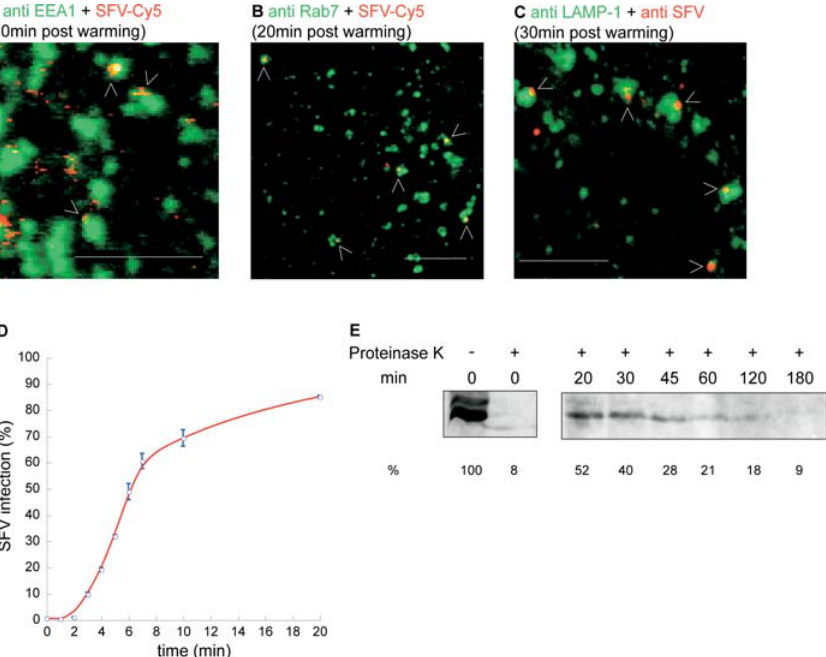
Figure 2. Internalization, Penetration, and Degradation SFV-Cy5 (at a MOI of 20) was allowed to bind to Vero cells for 60 min at 4 8 C, followed by transfer to 37 8 C for different time periods. (A) The cells were fixed and permeabilized 10 min after warming, followed by immunostaining using antibodies to EEA1. SFV-Cy5 is present in EEA1- positive endosomes. (B) The cells were fixed 20 min after warming and immunostained with anti-Rab7 antibodies. SFV-Cy5 is present in Rab7-positive endosomes. (C) Non-labeled SFV was used, and the cells were fixed and permeabilized 30 min after warming and immunostained with anti-LAMP-1 and anti-E1/E2 antibodies. SFV is present in endosomes positive for LAMP-1. (D) A FACS-based infection assay was used to determine the time course of SFV penetration during entry. Vero cells were infected with a MOI of one. NH 4 Cl was added at different time points to inhibit infection. Cells were further incubated at 37 8 C for 5 h, then fixed and immunostained for newly synthesized glycoproteins ( n ¼ 3). (E) Analysis of E1/E2 degradation was determined using immunoblotting. Virus (MOI of 50) was bound to Vero cells in the cold, and unbound virus was washed away. Cells were incubated for indicated times, and surface-associated viruses were removed by Proteinase K treatment. Cells were lysed, and after SDS-PAGE, immunoblotting was performed with an antibody against E1/E2. Note that contrary to non-reduced samples (Figure 1A), E1 and E2 co- migrate in SDS-PAGE after reduction. Scale bars represent 5 l m. DOI: